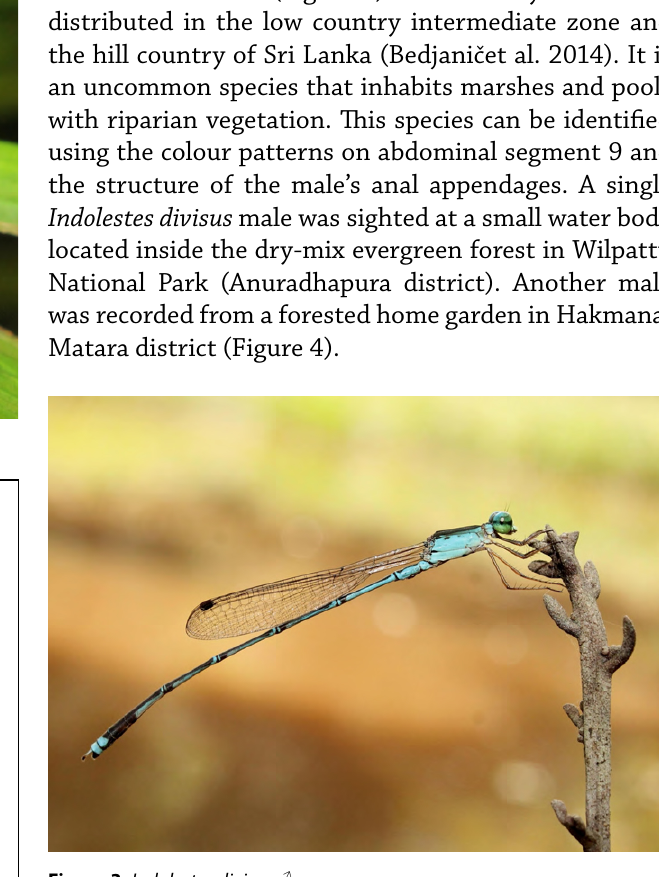
Figure 3. Indolestes divisus ♂